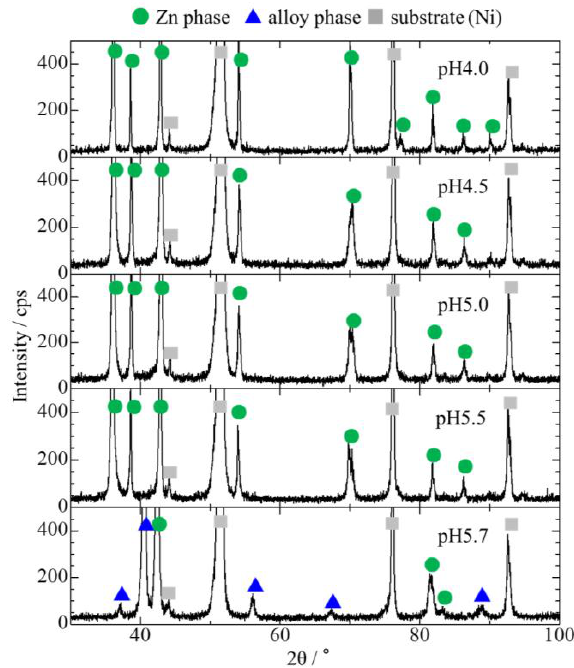
Figure 3. XRD patterns of the Zn–Fe–Mo plating deposited at various pH values.